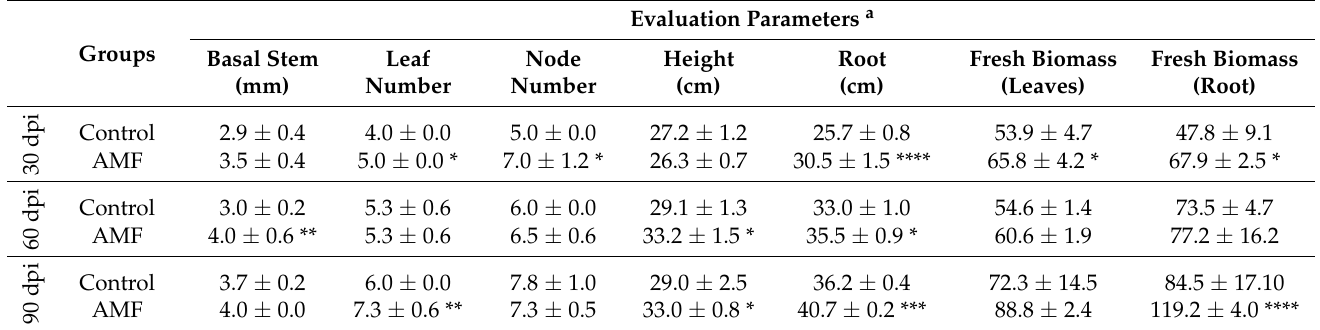
Table 2. Growth parameters of Piper divaricatum inoculated with AMF.